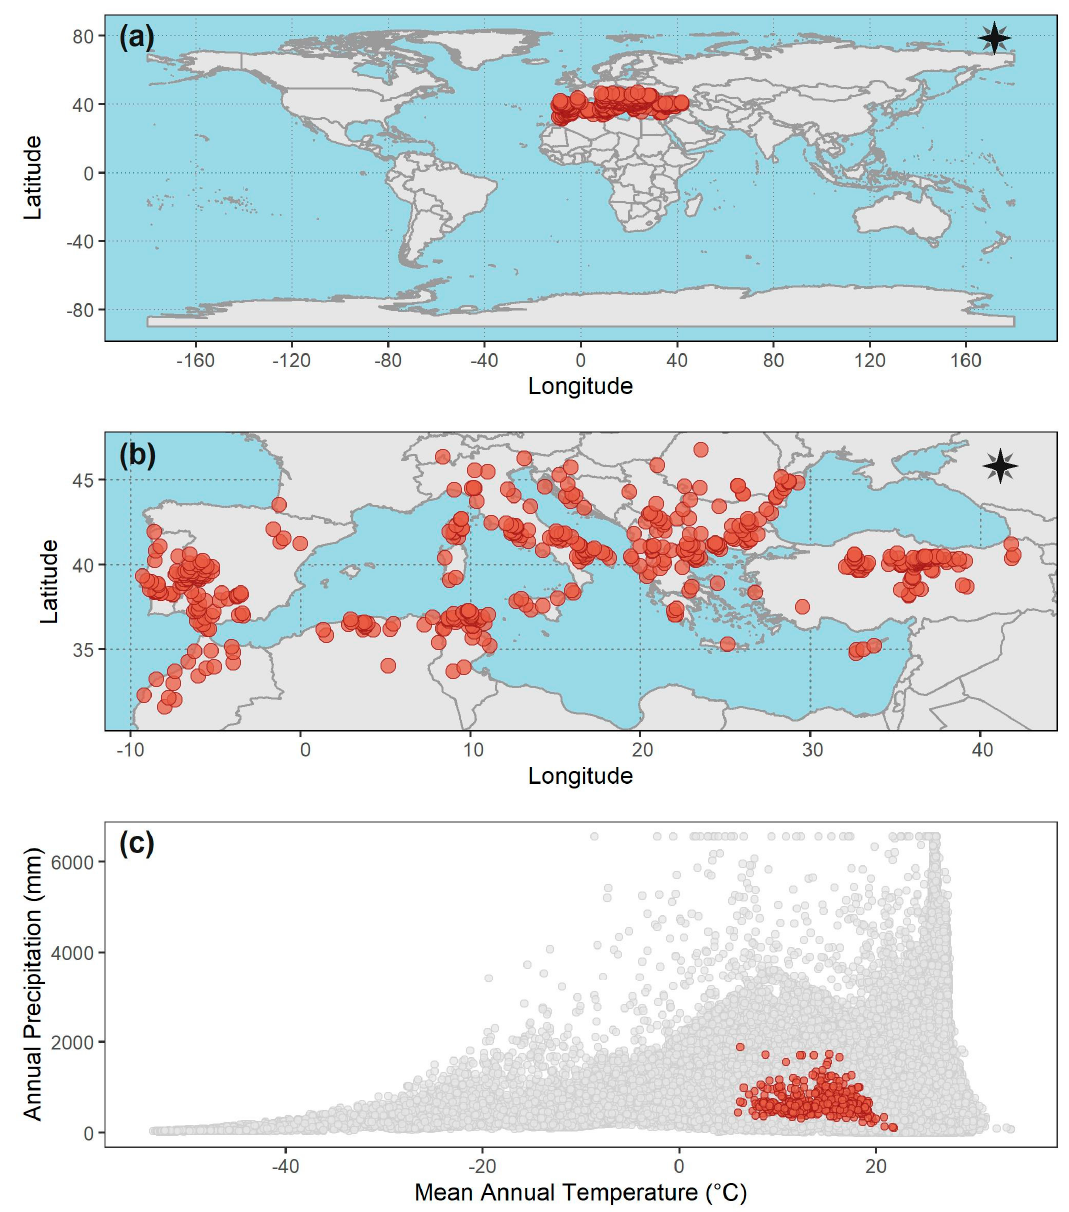
Figure 1. Representation of the Hutchinson’s duality between the geographical and environmental spaces occupied by Hyalomma marginatum tick, the main vector of the Crimea-Congo virus [48] (occurrence records were downloaded from the VectorMap data portal [http://www.vectormap.si.edu], accessed